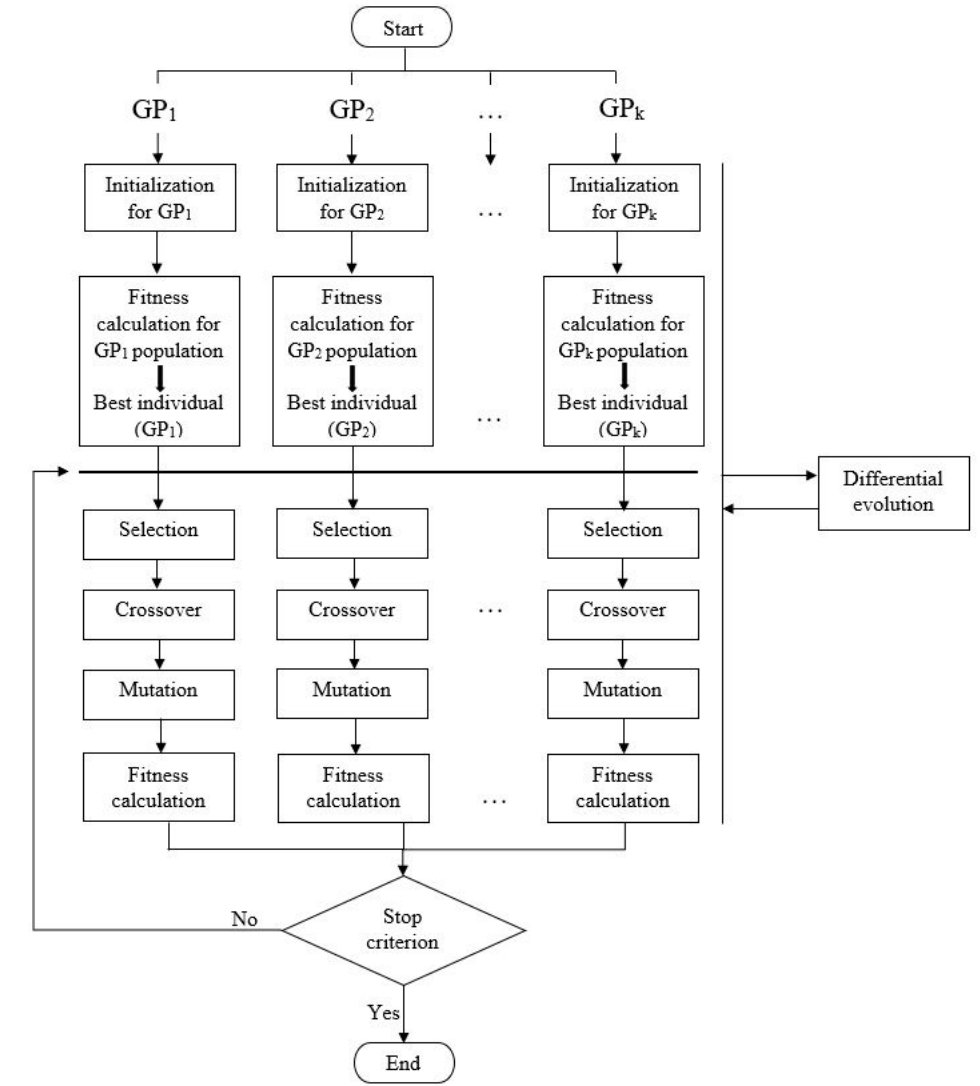
Figure 4. Scheme of the evolutionary approach EvolDES for the identification of dynamical systems in the form of an ODE system.